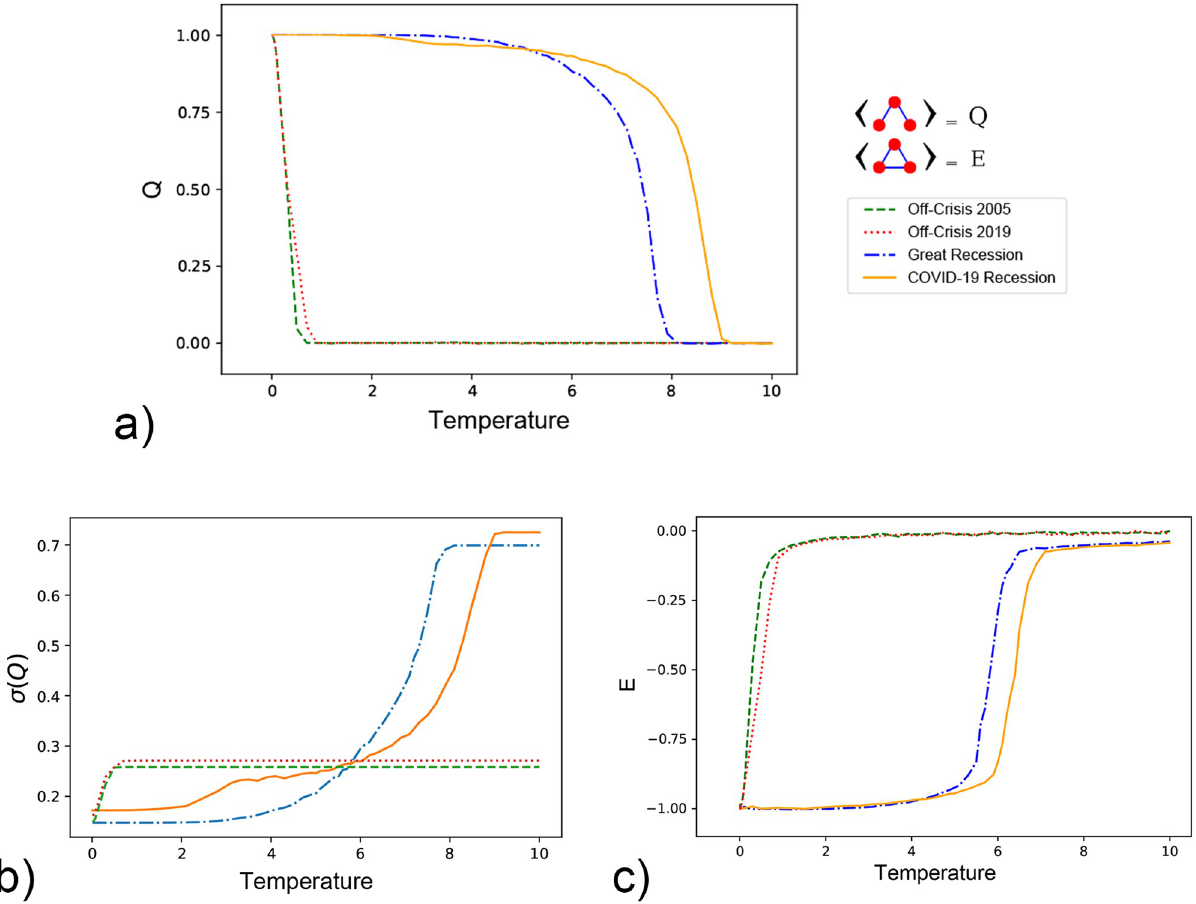
Fig 4. The behavior of order parameter, Q, and σ ( Q ), and the Energy versus temperature. a) The mean value of weighted two-stars, Q , versus temperature in two different on-crisis periods (the left figure). The Q equals 1 in low temperature while increasing temperature, T , will result in destroying the ordered structure of the network and zero value of the Q in the random configuration of the network. In off-crisis periods the value of Q is different from zero around approximately zero temperatures and it will quickly reduces to zero due to the weak correlation between stocks, b) The standard deviation(std) of the two-star weights versus the temperature (the middle figure). The std is larger for T > T c in both on and off-crisis periods , and in on-crisis with respect to off-crisis we see bigger values of std; this is caused by the difference in correlations, c) The energy of the than T < T c network versus temperature (the right figure). In the on-crisis, the structural order of the network resists against changes hence it is needed to increase the temperature to a critical value that can overcome the ordered phase. In off-crisis periods the structure of the network is not in an ordered phase so a small amount of disorder can push the network in a random configuration and zero value of energy.